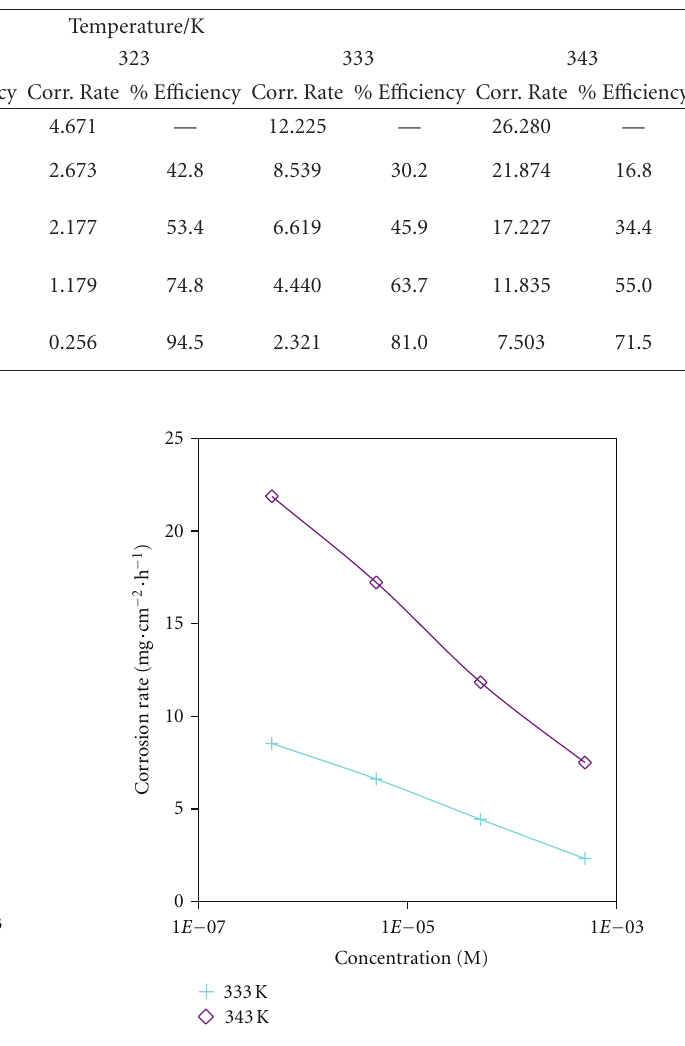
Figure 5: E ff ect of concentration of 3-Benzoylmethyl benzim- idazolium hexafluoroantimonate (BMBI) on the corrosion rate (mg · cm − 2 · h − 1 ) of mild steel in 1.0 M HCl at various